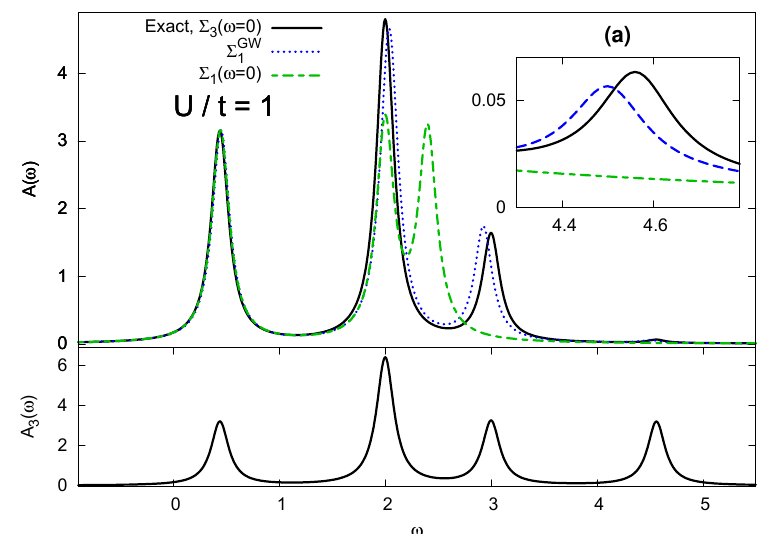
Figure 2: The addition part of the the 1- and 3-body spectral functions for the Hubbard dimer at 1/4 filling at weak interaction ( U / t = 1 ). Top panel: the spec- tral function A ( ω ) obtained with various levels of theory: the exact 1-GF and the 1-GF obtained from the exact static 3-SE (black solid line); the GW approxima- tion (blue dotted line); the exact static 1-GF (green dashed line). Inset (a): zoom of the satellite peak. Bottom panel: the exact 3-body spectral function A = 1 . spectra correspond to ε 0